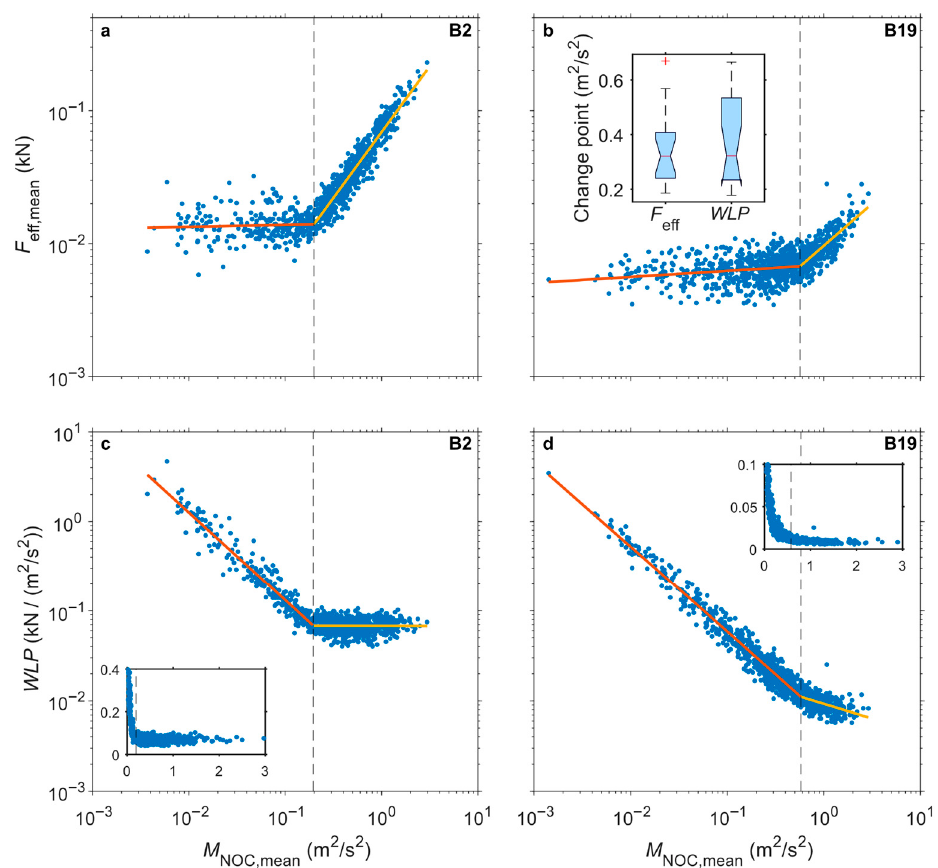
Figure 7. ( a , b ) Dependence of 10 min mean effective force ( F eff,mean ) on 10 min mean low-pass filtered momentum flux ( M NOC,mean ) of trees B2 (thickest tree with DBH = 28.6 cm) and B19 (thinnest tree with DBH = 19.3 cm). ( c , d ) Dependence of the tree-specific wind load parameter ( WLP ) on M NOC,mean . The red and orange lines represent the two phases of a linear regression before and after a change point. The inset in ( b ) shows the distribution of WLP and F eff values of B1 to B20 as boxplots. The boxplot notches indicate the 95% confidence interval around the median. The insets in ( c , d ) show the relationships between WLP and M NOC,mean in a linearly scaled coordinate system.